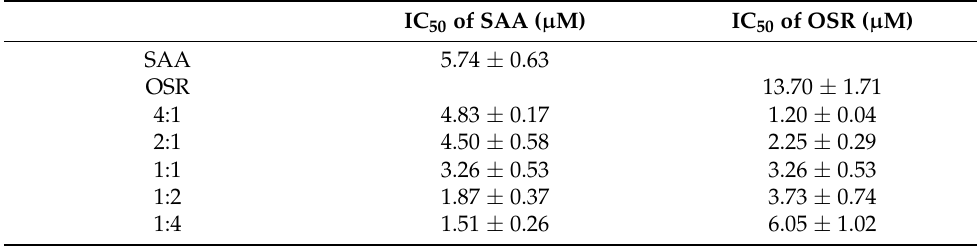
Table 3. IC 50 values of SAA and OSR, either alone or in a two-drug